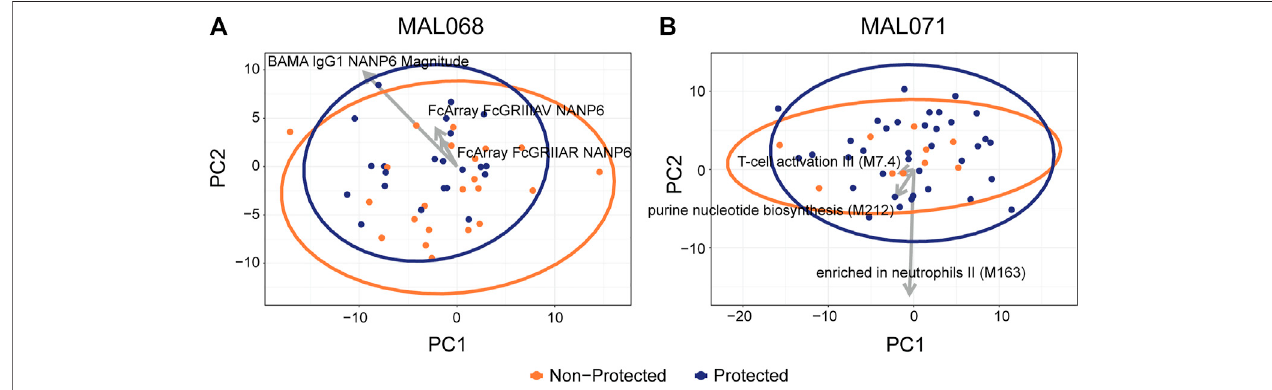
FIGURE 4 | Scatterplots of participant factor scores on the fi rst (PC1) and second (PC2) principal components of a principal components analysis on (A) MAL068 data(ARRandRRRarms); (B) MAL071data(RRRandRRrarms).ArrowsshowthefactorloadingsforthetopthreevariablesbyCV-AUCforeachdataset.Atotalof220 features were used in the PCA analysis, 133 of which are RNA-seq BTMs.